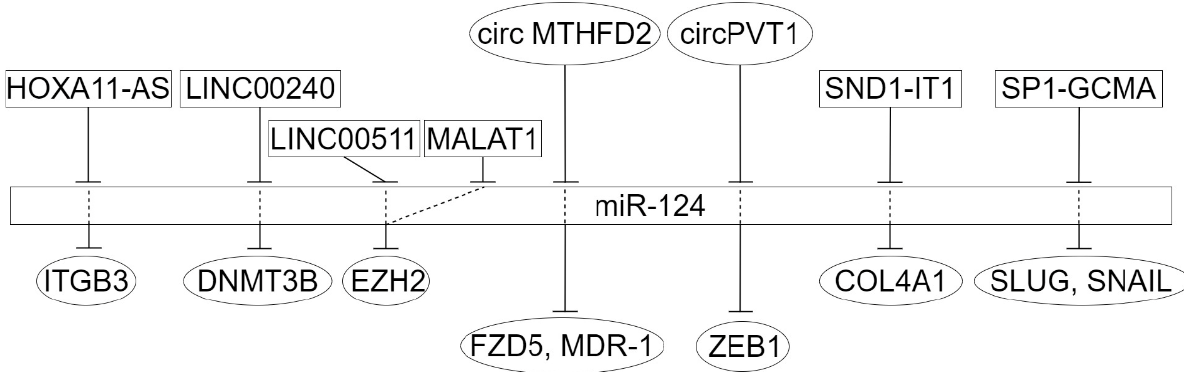
Figure 4. MiR ‐ 124 regulatory sub ‐ network in gastric cancer. LncRNAs are given inside the rectan ‐